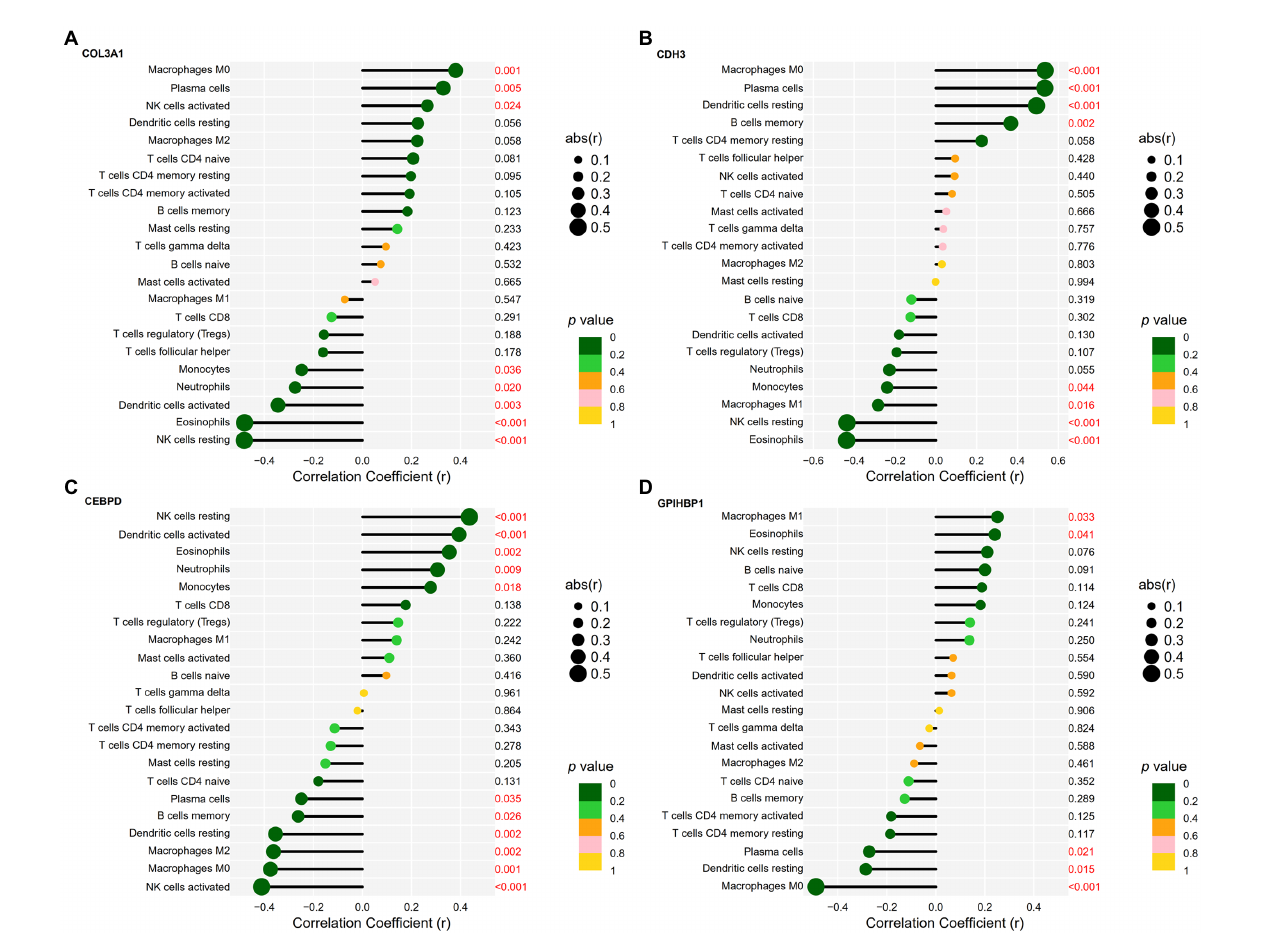
FIGURE 7 Correlation between candidate genes and infiltrating immune cells in IPF. (A) Correlation between COL3A1 expression and the infiltration levels of immune cells in IPF. (B) Correlation between CDH3 expression and the infiltration levels of immune cells in IPF. (C) Correlation between CEBPD expression and the infiltration levels of immune cells in IPF. (D) Correlation between GPIHBP1 expression and the infiltration levels of immune cells in